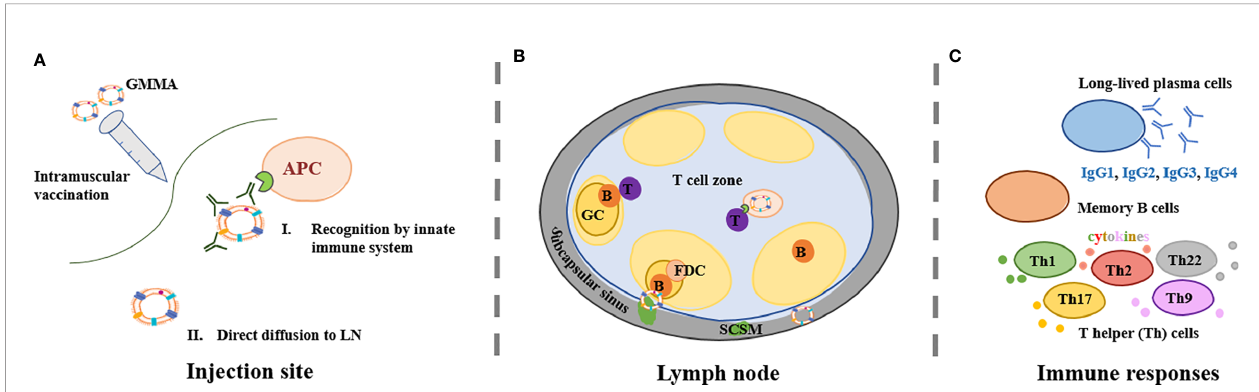
FIGURE 1 | GMMA mechanism of action. (A) GMMA vaccines have been administered intramuscularly. At the injection site, GMMA may be coated by proteins present in the interstitial fl uid. The kind and amount of these proteins is in fl uenced by GMMA size and physico-chemical properties. GMMA traf fi cking to the lymph node (LN) may require cellular transport from antigen presenting cells (APCs) (A-I) but GMMA can also be able to drain freely to the LN (A-II) . (B) Upon arrival into the LN, GMMA and APCs circulate into the LN subcapsular sinus where subcapsular sinus macrophages (SCSM) reside. SCSM can uptake GMMA in complex with IgG and can reach the LN follicular area where they transfer the antigen to B cells. B cell receptor crosslinking and B cell activation is facilitated by repetitive display of optimally spaced antigen on GMMA. Also follicular dendritic cells (FDCs) play a major role in germinal center (GC) kinetics and in the development of humoral responses. GMMA delivered to the LN via active transport are presented to naïve T cells with antigen-cognate T cell receptors in the T cell zone. T cells also interact with activated B cells, that present them antigen-derived peptides thus providing T cell ‘ help ’ to B cells, sustaining their activation and driving the formation of GCs. (C) GMMA drive the selection of B cell clones with high antigen af fi nity into long-lasting memory B cells and/or long-lived antibody-producing plasma cells and possibly the differentiation of T cells in different subsets of T helper (Th)